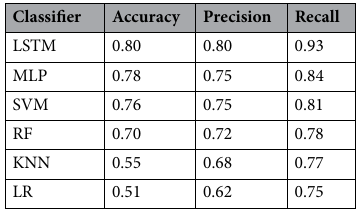
Table 1. SA prediction performance for 10 days lead scenario.